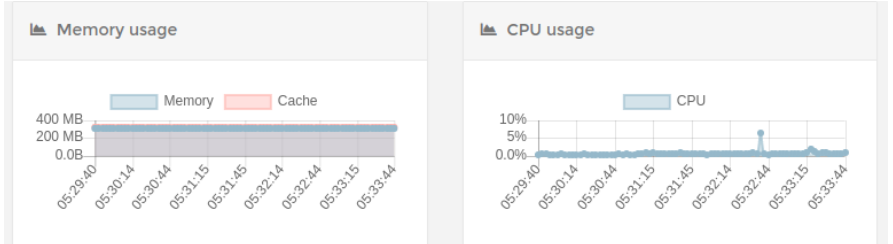
Figure 15. Docker CPU and memory utilization for the instance serving RPC and transactions for the clients during the test.